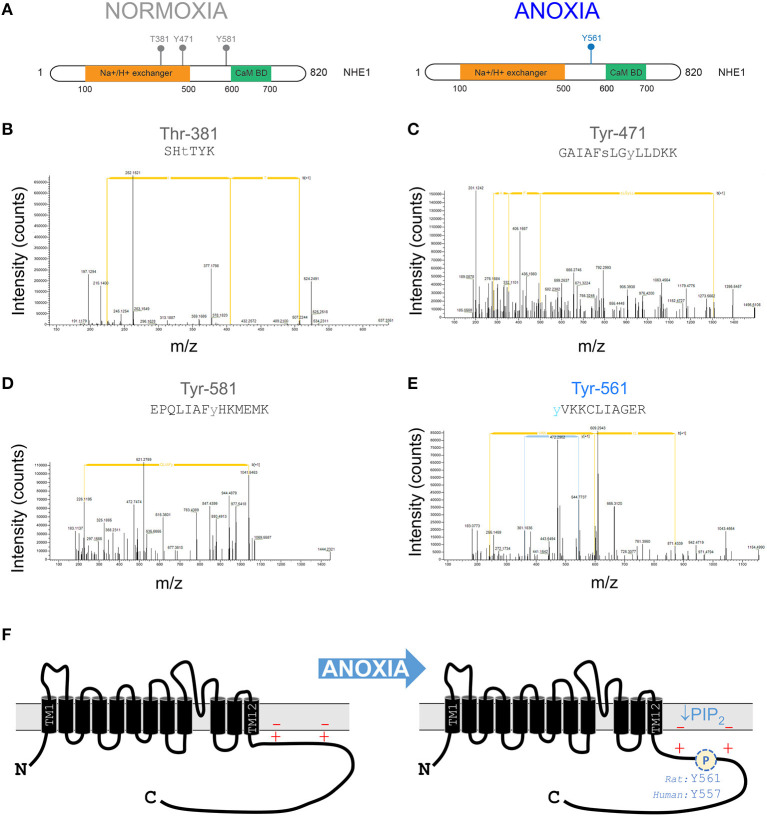
Anoxia changes the phosphorylation pattern at the NHE1 C-terminus. (A) Phosphorylation sites identified by tandem mass spectrometry-based proteomics analysis on NHE1 pulled-down from rat hearts Langendorff-perfused with either anoxic (n = 4) or normoxic (n = 4; control) buffers for 15 min prior to sample collection. Threonine residue at position 381 (T381) and tyrosine residues at positions 471 (Y471) and 581 (Y581) were identified in normoxia conditions, while tyrosine residue at position 561 (Y561) was identified in hypoxia conditions only. The Na+/H+ exchanger region and calmodulin binding domain (Cam BD) are highlighted in orange and green, respectively, on NHE1 protein. (B–D) Tandem mass spectra containing phosphorylated T381, Y471, Y581, and Y561 residues matching the corresponding peptide ions in (B) SHTTIK (z = +2, m/z = 383.68954), (C) GAIAFSLGYLLDKK (z = +2, m/z = 849.36743), (D) EPQLIAFYHKMEMK (z = +3, m/z = 615.64807) and (E) YVKKCLIAGER (z = +3, m/z = 472.89618) are shown. (F) Schematic of NHE1 protein structure, showing positively charged lipid interacting domain of the C-terminus. Anoxia leads to phosphorylation which weakens the otherwise activatory interaction with negatively charged PIP2 in the inner leaf of the sarcolemma. Additionally, metabolic inhibition will deplete PIP2 levels.